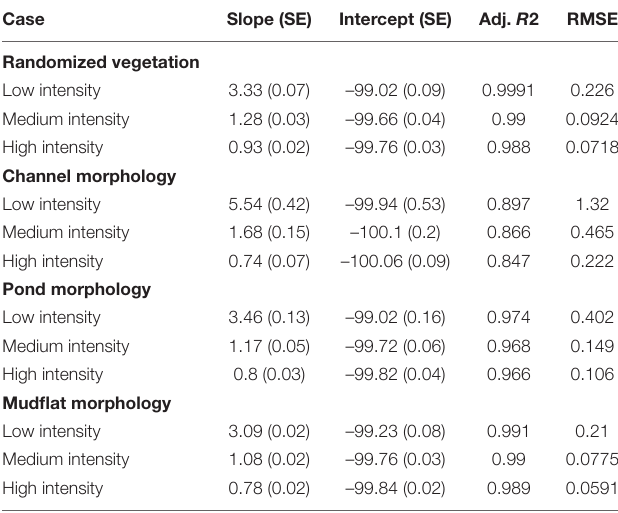
TABLE 2 | Values for linear regressions in the form of y = mx + b, where y represents percent change in wave energy and x represents unvegetated/vegetated ratio (UVVR).